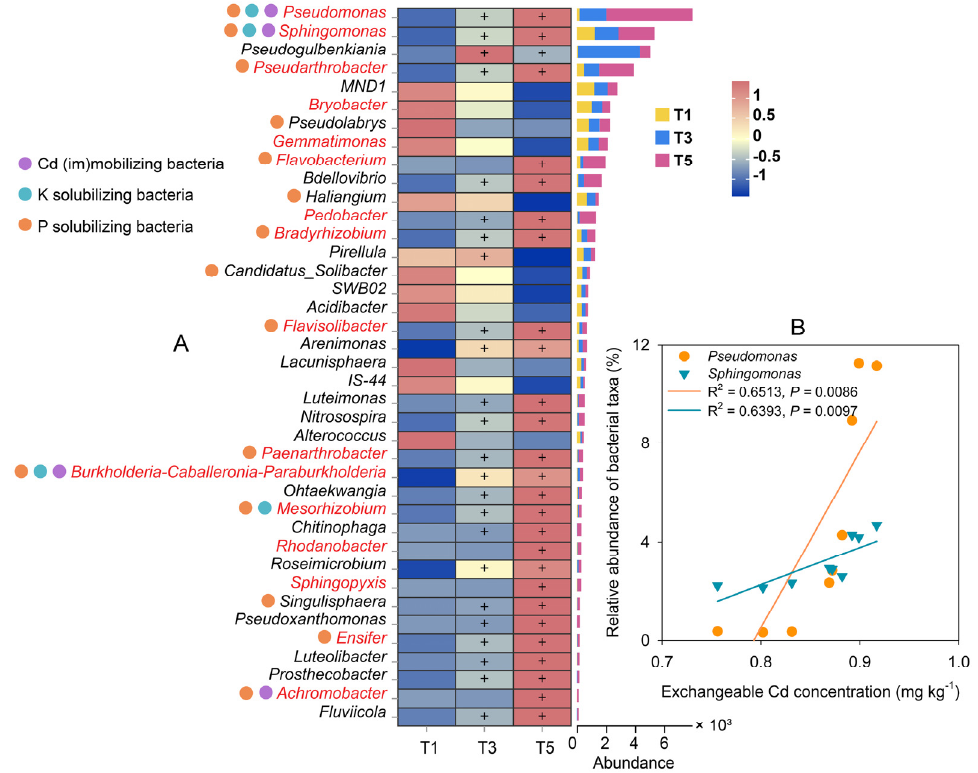
Figure 5. Dynamic heatmap and stacked graph showing the enriched bacterial genera ( A ) and correlation analysis between relative abundance of bacterial taxa and soil exchangeable Cd concentration ( B ) in C. grandiflora rhizosphere soils supplemented with 2 (T3) and 8 (T5) g kg − 1 GABA compared with the control soil (T1). The relative abundances of bacterial genera in the graph are normalized at the row level of the heatmap. The plus (+) sign indicates the rhizobacteria enriched in the T3 and/or T5 soils. Bacterial genera in red font indicate plant growth-promoting rhizobacteria, and bacterial genera marked with purple, green, and orange circles indicate rhizobacteria involved in Cd mobilization/immobilization, K solubilization, and P solubilization, respectively.